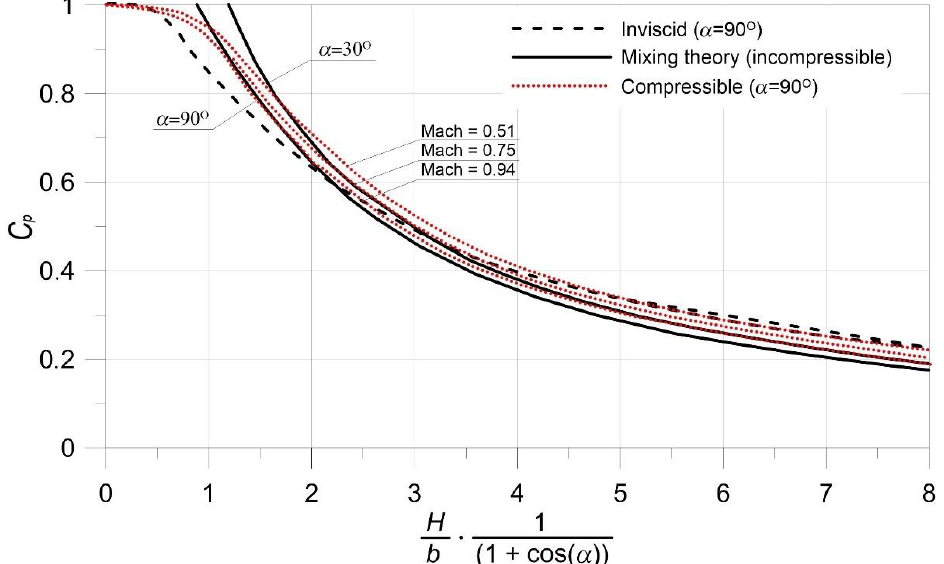
Figure 2. Comparison of pressure coefficient C p calculated using inviscid and incompressible fluid flow, mixing theory, and compressible fluid flow [24 – 26].